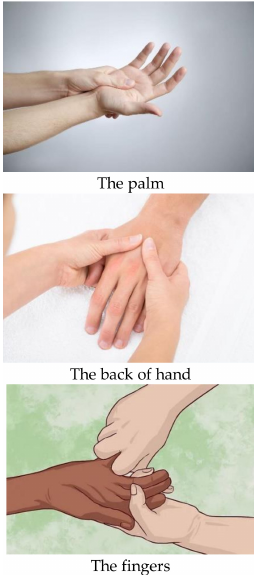
Figure 3. The points of hand